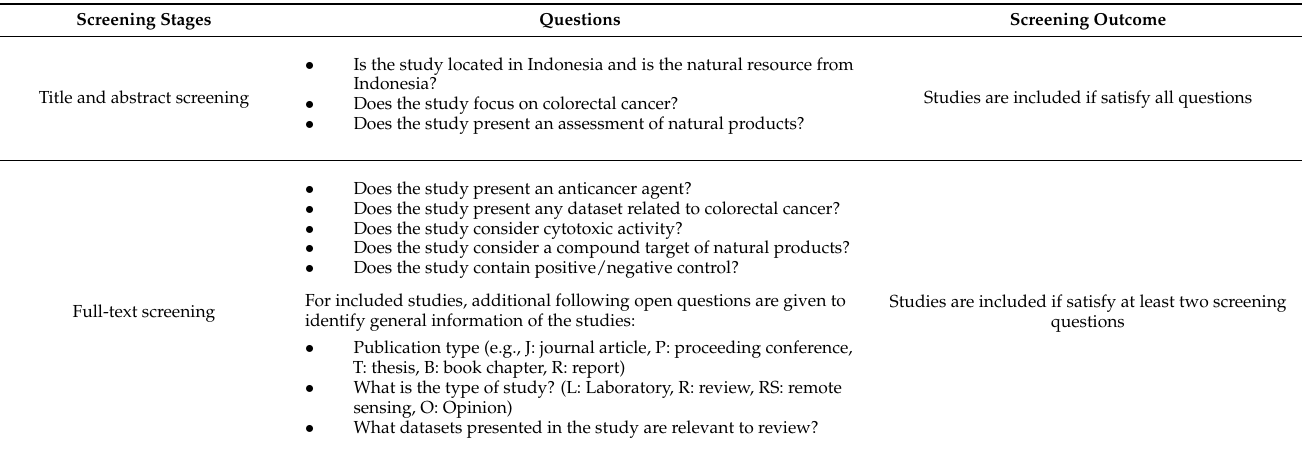
Table 3. List of questions used for studies inclusion and exclusion during combined title and abstract, and full-text screen-